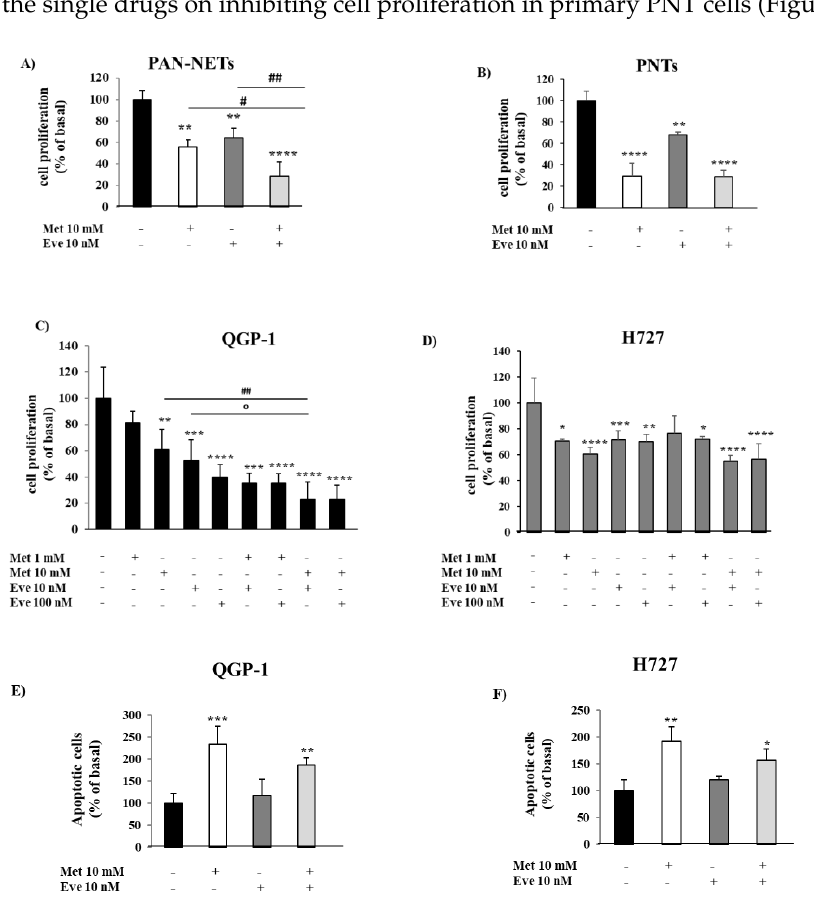
Figure 1. The effect of metformin (Met) and everolimus (Eve) on neuroendocrine tumor (NET) cell proliferation and apoptosis. ( A , B ) To measure cell proliferation, we incubated primary NET cells with metformin 10 mM and everolimus 10 nM, alone or in combination, for 24 h, then with BrdU for 24 h. Experiments were repeated 3 times and each determination was done in triplicate. Basal = untreated